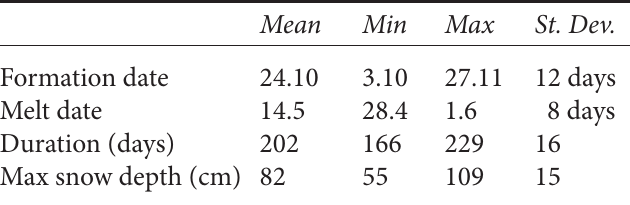
Table 3. Mean, minimum, maximum and standard deviation of snow amount and duration parameters in Muonio during 1972/1973-